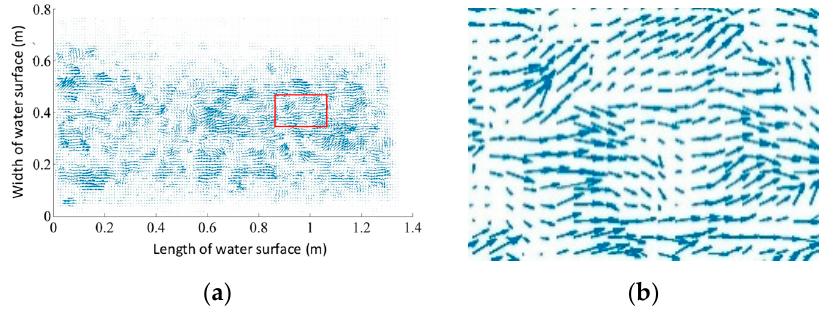
Figure 3. Vector velocity distribution map ( a ) and its local enlargement map ( b ).